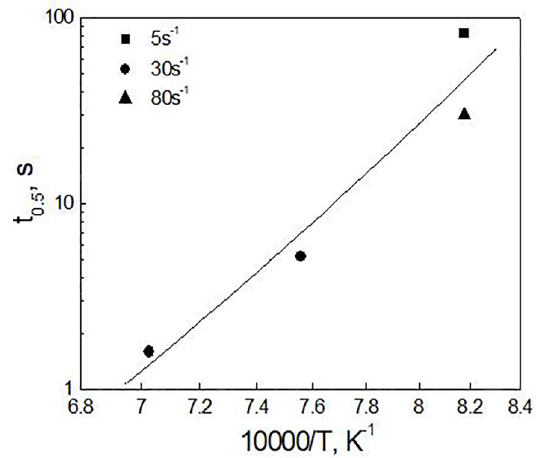
Figure 4. Effect of annealing temperature on time to 0.5 fraction of recrystallization. 3.2. Prediction of recrystallization kinetics